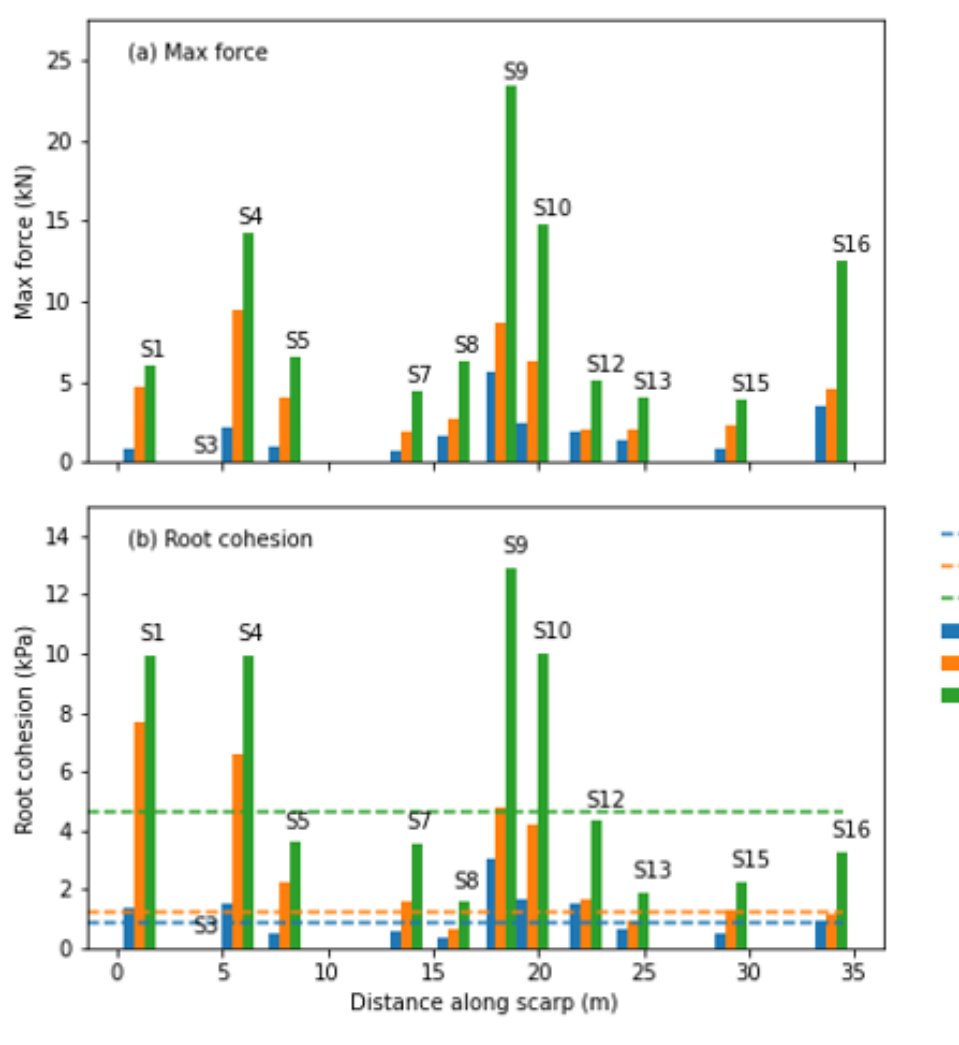
Figure 11. Maximum activated force ( a ) and root cohesion ( b ) calculated independently for each scarp segment, showing lateral variation along the perimeter of the landslide scarp. Panel ( a ) shows maximum activated force, and ( b ) shows root cohesion, with the scarp-averaged cohesion superimposed as horizontal dashed lines for comparison. Both quantities are calculated within each segment along the length of the scarp perimeter; negligible roots intersecting the basal surface are not included. S1 through S16 denote the scarp segments depicted in Figure 4a.